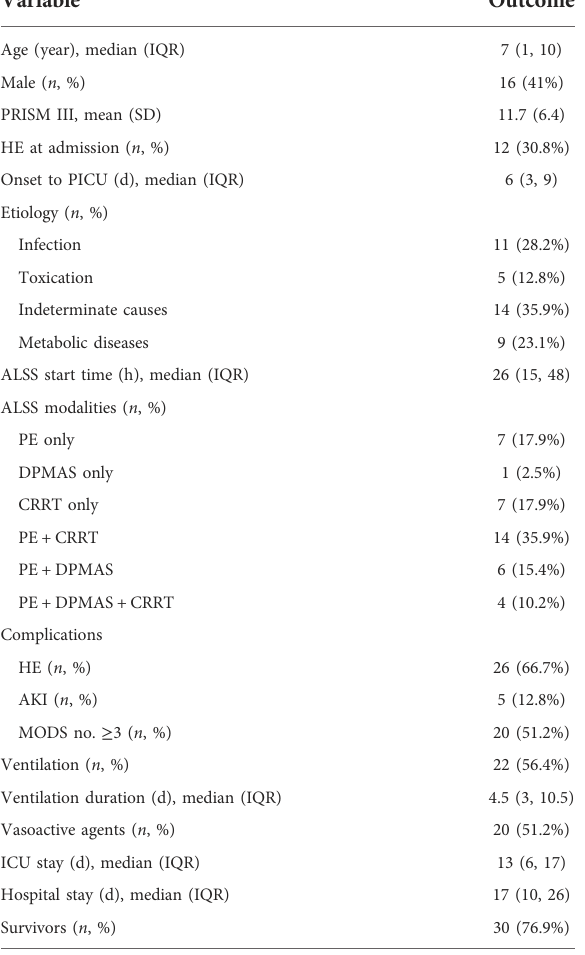
TABLE 1 Baseline characteristics of the study population ( n